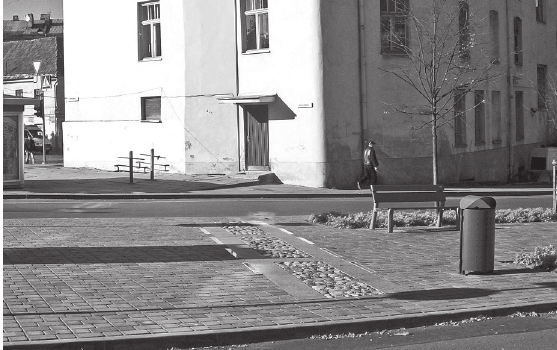
Fig. 6. The site of Vilnius defense wall between Bazilionų, Visų Šventųjų ir arklių streets, 2011